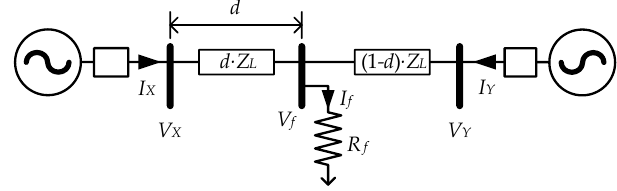
Figure 5. Simplified line model for general multi-end